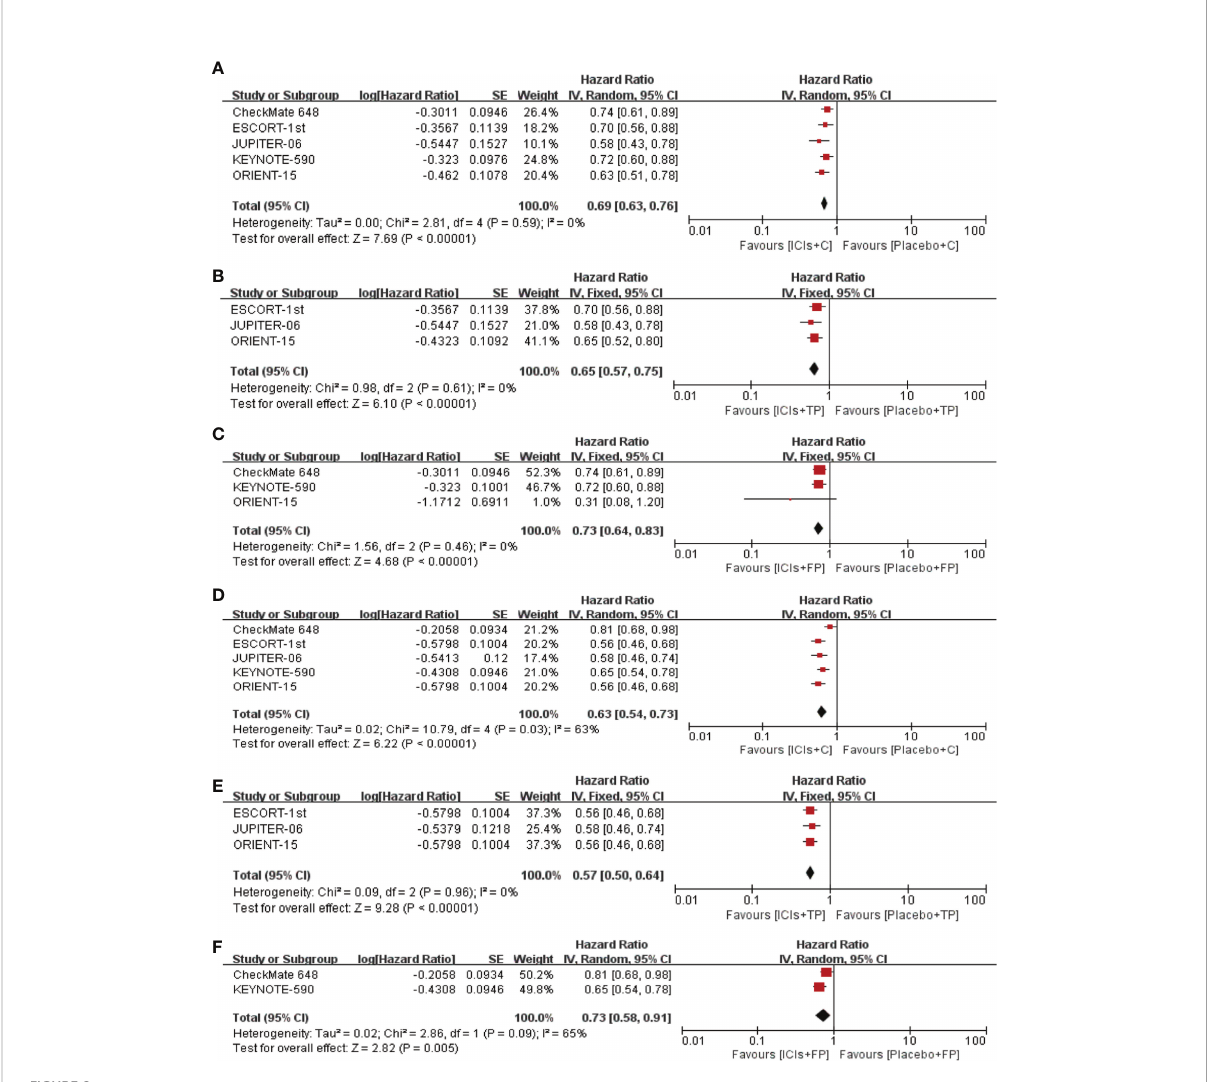
FIGURE 2 Pooled HR of OS between ICIs+C and placebo+C (A) , ICIs+TP and placebo+TP (B) , ICIs+FP and placebo+FP (C) . Pooled HR of PFS between ICIs+C and placebo+C (D) , ICIs+TP and placebo+TP (E) , ICIs+FP and placebo+FP (F) . HR, Hazard ratio; OS, overall survival; PFS, progression free survival; ICIs, immune checkpoint inhibitors; C, chemotherapy; TP, taxane plus platinum; FP, fl uorouracil plus